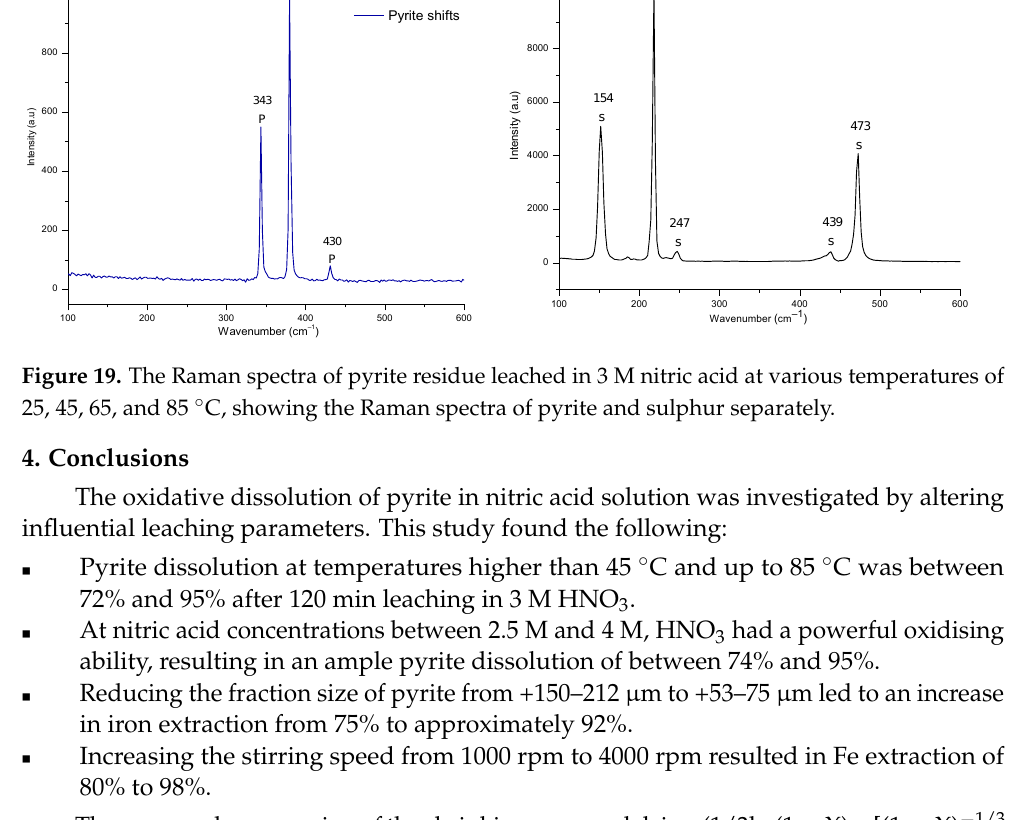
Figure 19. The Raman spectra of pyrite residue leached in 3 M nitric acid at various temperatures of 25, 45, 65, and 85 °C, showing the Raman spectra of pyrite and sulphur separately.